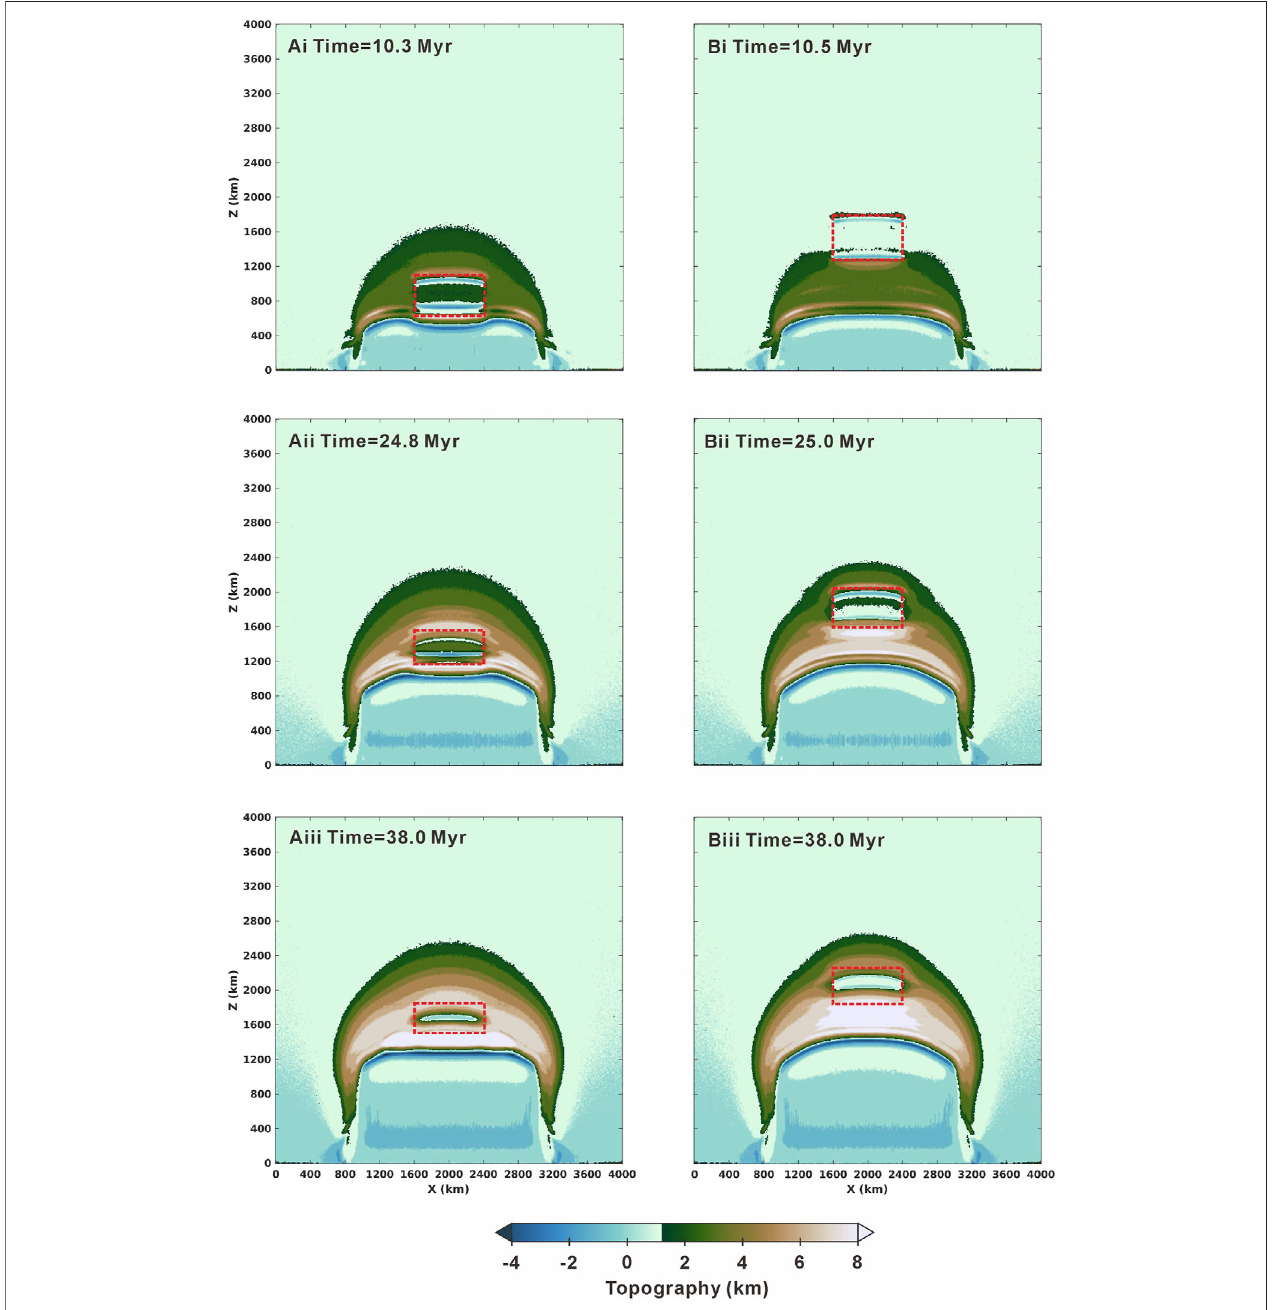
FIGURE 6 | Topographic evolution of the model-2 and model-3 ( Table 2 ). Snapshots showing the surface topography of model-2 at (Ai) 10.3 Myr (Aii) 24.8 Myr, and (Aiii) 38.0 Myr. Snapshots showing the surface topography of model-3 at (Bi) 10.5 Myr (Bii) 25.0 Myr, and (Biii) 38.0 Myr. The red dashed rectangles outline the scope of the strong